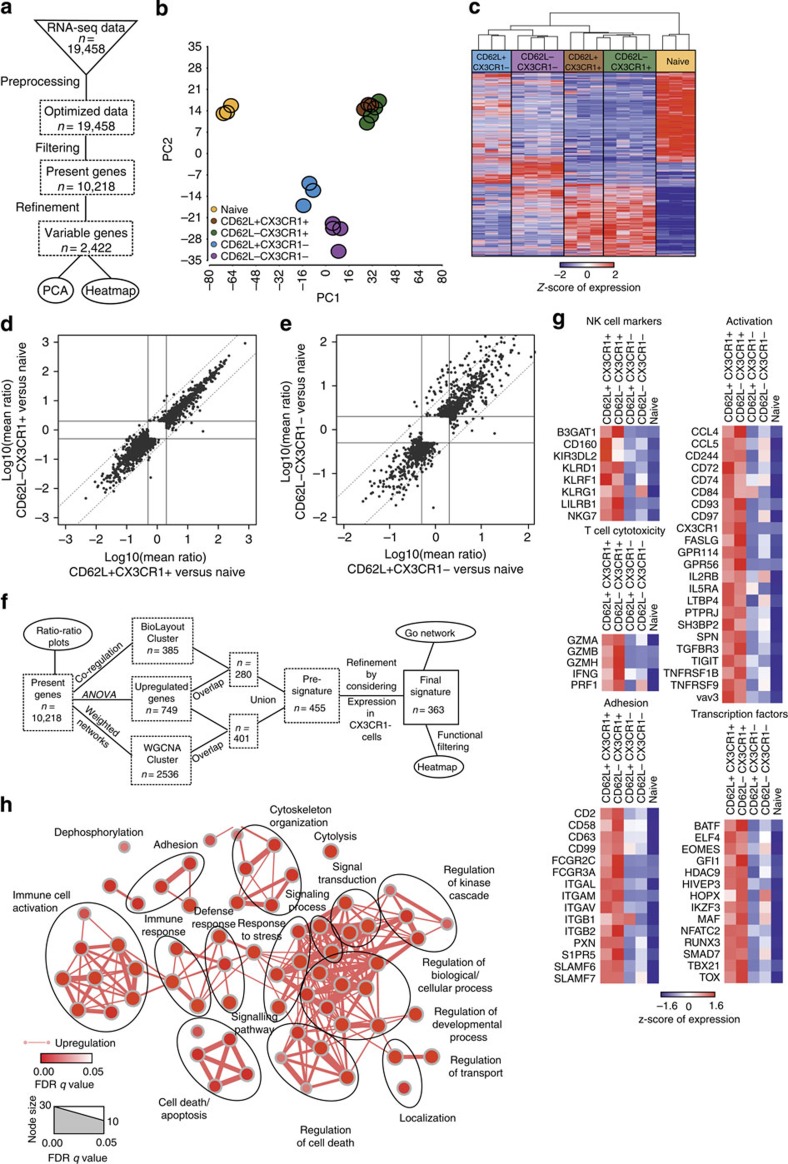
Transcriptome analysis reveals a core signature of human CX3CR1-expressing memory CD8+ T cells with effector function.(a) Scheme describing the workflow for RNA-seq data preprocessing and filtering. (b) Principal component analysis (PCA) based on present and variable genes. (c) Heat map showing the z-transformed expression values of present and variable genes, coloured from blue to red. (d) Ratio–ratio plot of log10-transformed mean ratios of genes that are differentially expressed (fold change (FC) <−2 or >2; FDR-corrected P-value <0.05) comparing CD62L+ CX3CR1+ T cells versus naïve T cells (x axis) or CD62L− CX3CR1+ T cells versus naïve T cells (y axis). (e) Ratio–ratio plot of log10-transformed mean ratios of genes being differentially expressed FC <−2 or >2; FDR-corrected P-value <0.05) comparing CD62L+ CX3CR1− T cells versus naïve T cells (x axis) or CD62L− CX3CR1− T cells versus naïve T cells (y axis). (f) Schema describing the workflow for generating the transcriptome core signature for CX3CR1+ T cells. (g) Heat map of selected genes out of the 363-gene core signature sorted by defined activity groups. Gene expression values were z-transformed for visualization and are coloured from blue to red. (h) Network visualization of Gene Ontology Enrichment Analysis based on the 363 core signature genes using BiNGO and EnrichmentMap. Enriched GO terms are depicted by red nodes, where colour and size represent the corresponding FDR-adjusted enrichment P-value (q-value). Overlap of genes between nodes is indicated by edge thickness.